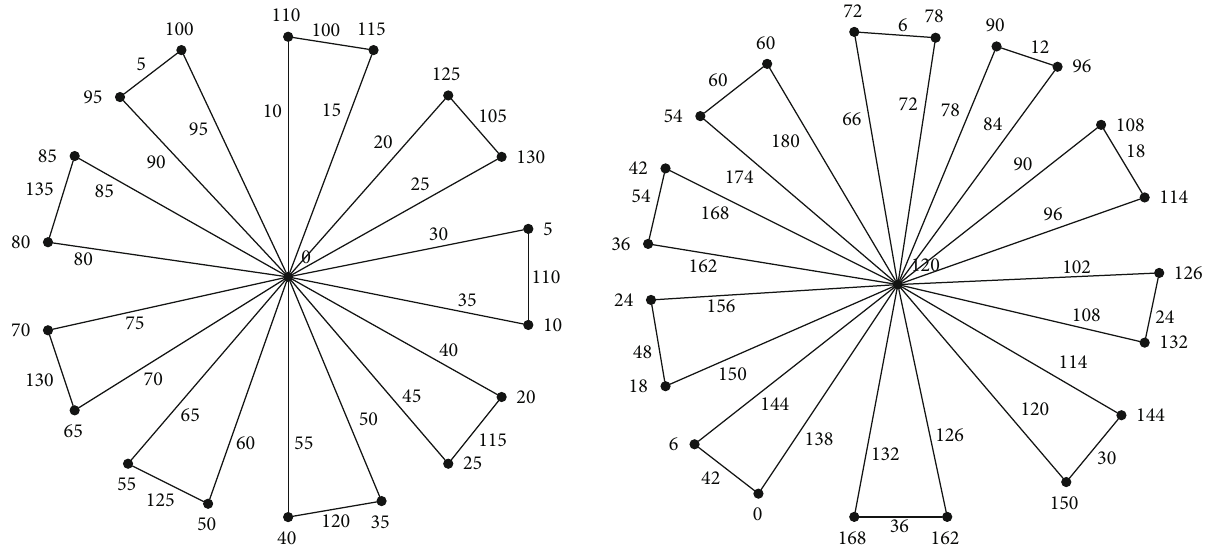
Figure 18: The friendship graphs Fr